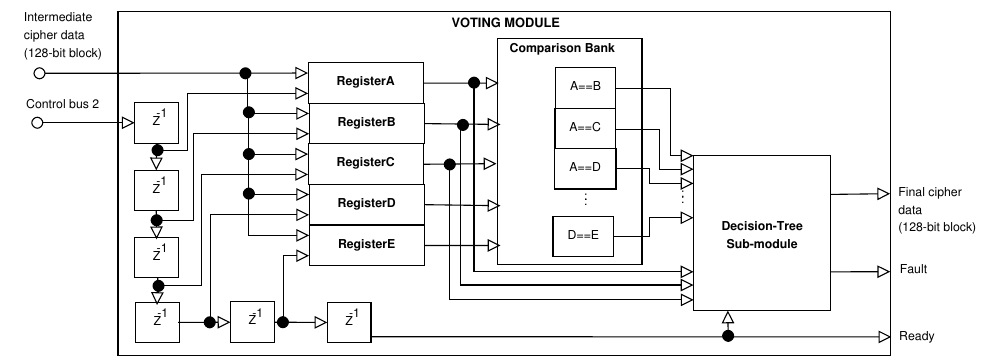
Figure 3. Block diagram of the Voting Module.